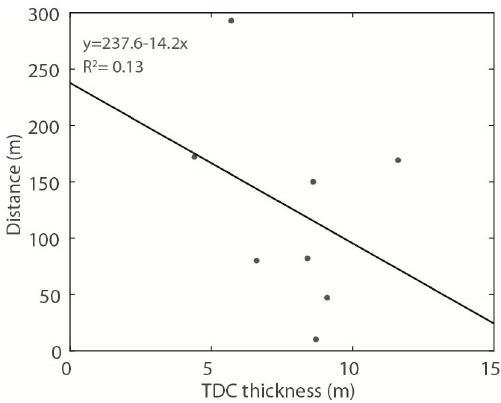
Figure 12. Cross plots of TDC thickness vs. distance to well’s nearest fault.